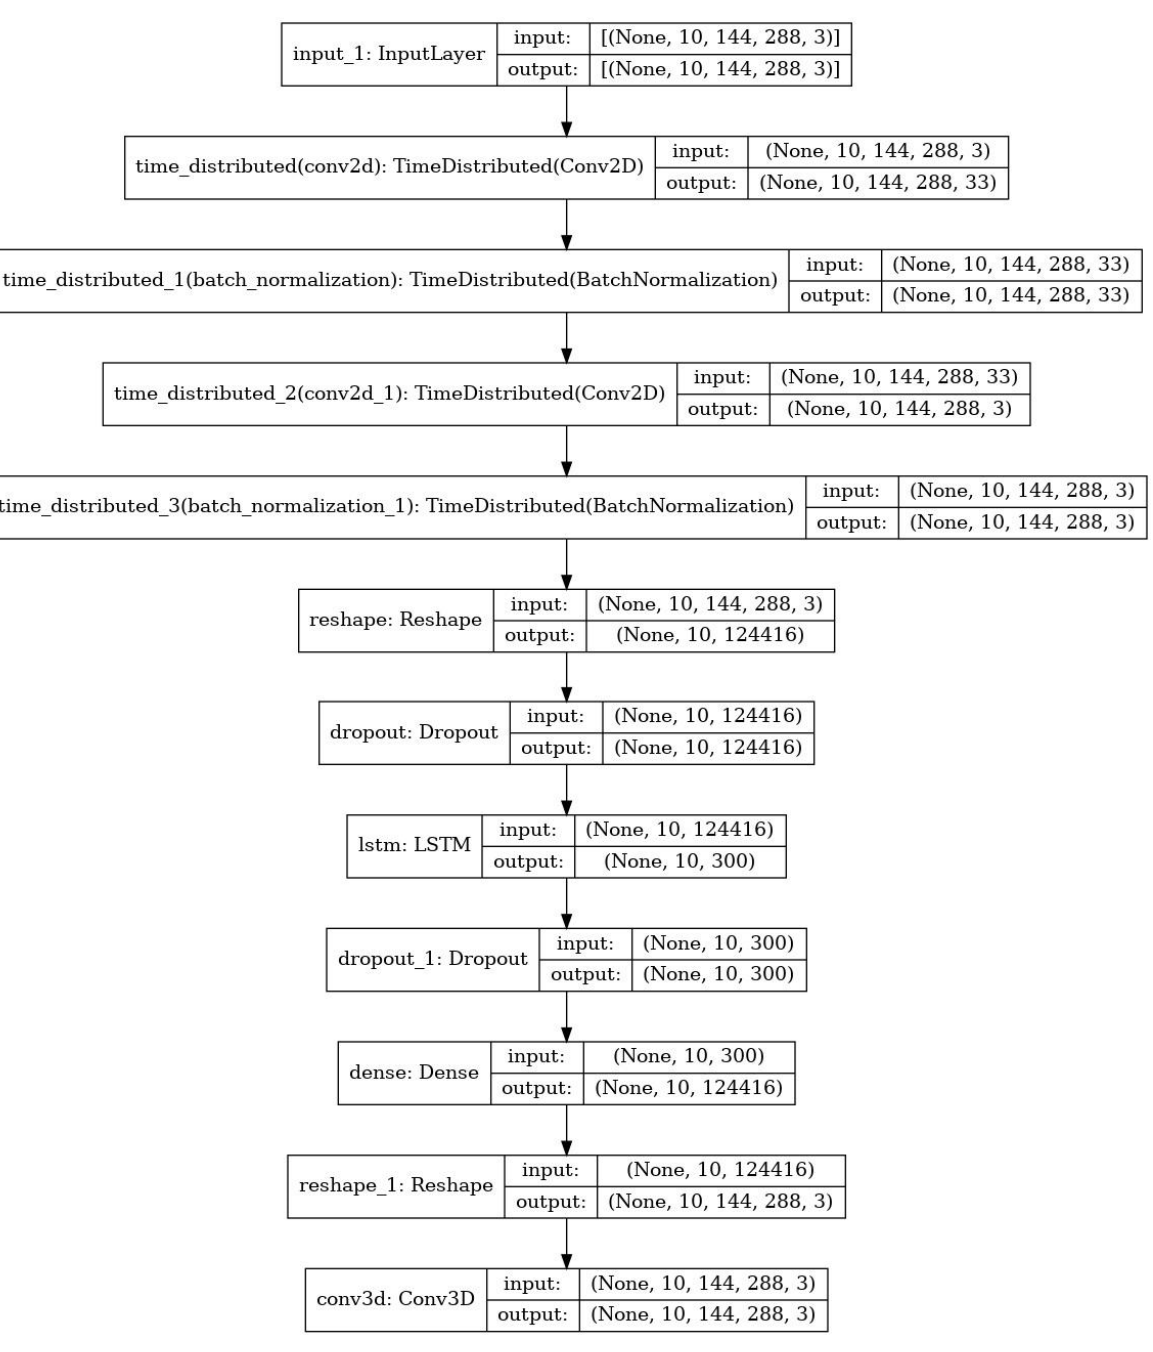
Figure 2. Plot of CNN-LSTM developed model for sequence-to-sequence